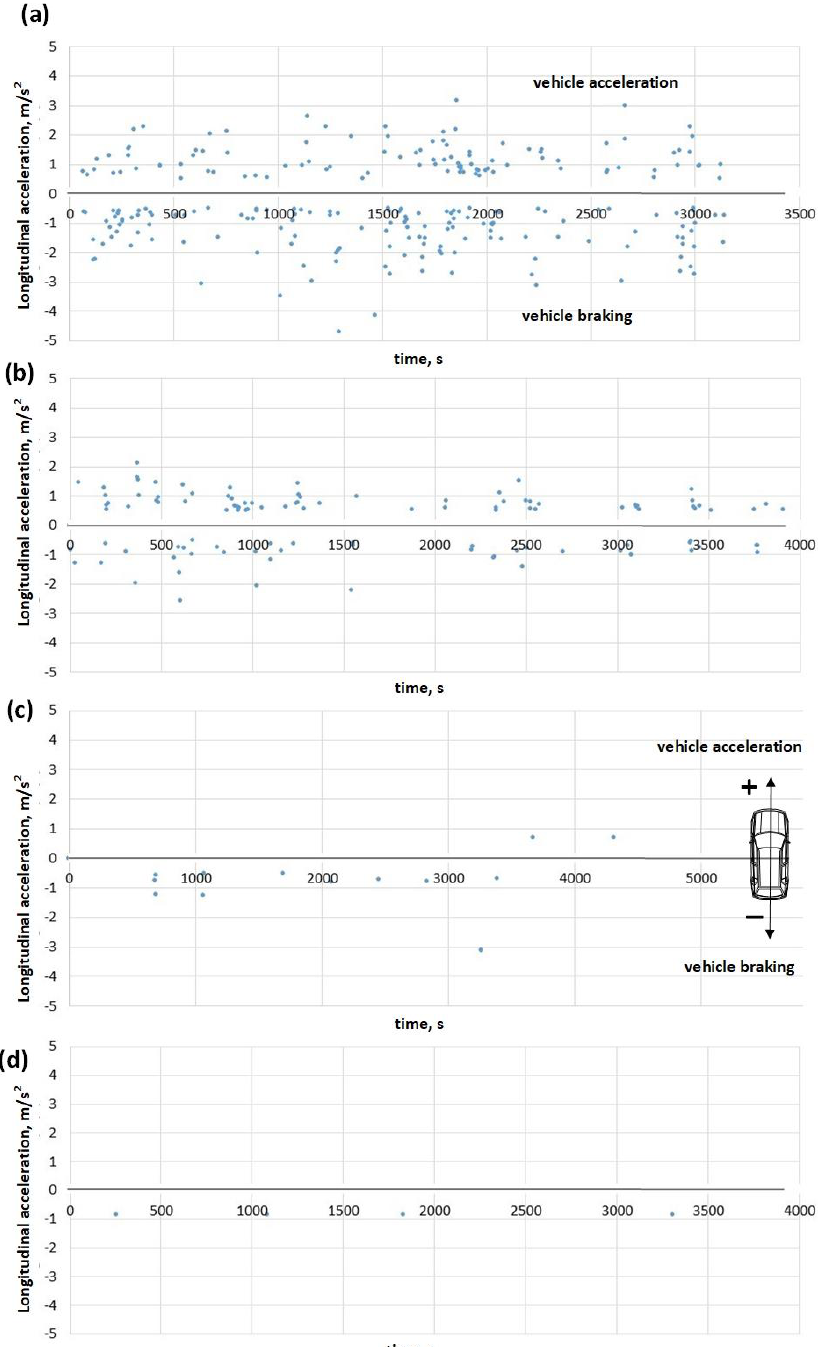
Figure 6. Longitudinal acceleration extreme values in the acceleration and braking maneuvers in the various sections of the route: ( a ) city road; ( b ) suburban road; ( c ) expressway (dual carriageway); ( d ) highway.